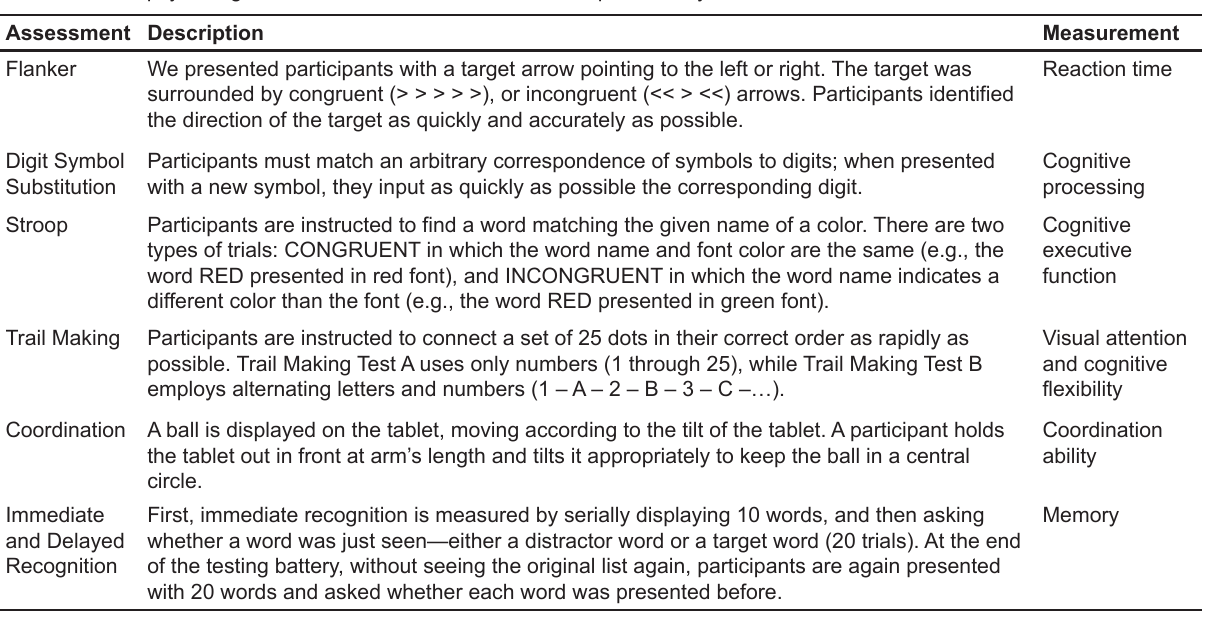
Table 1. Neuropsychological assessments in the BrainCheck Sport Battery Assessment